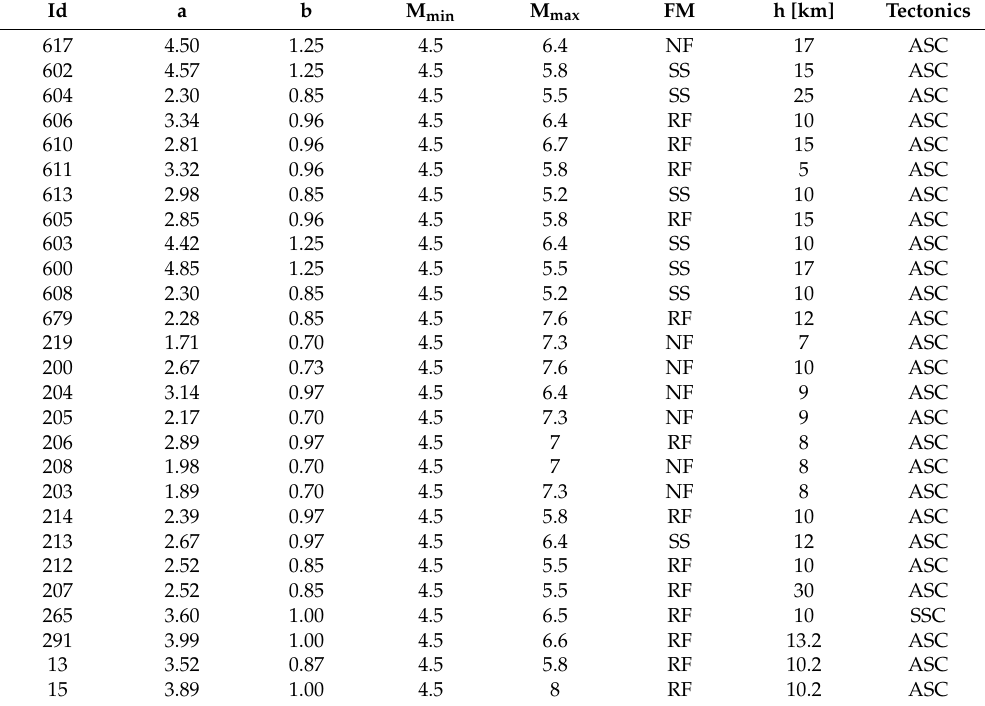
Table 8. Seismic characterization of each A1MPS16 zone [72]. a and b are the parameters of the Gutenberg–Richter distribution. M min and M max are the minimum and maximum moment magnitudes for PSHA. FM: Focal Mechanism; NF: Normal Faulting; SS: Strike-slip; RF: Reverse Faulting. h: Reference depth. ASC: Active Shallow Crust; SSC: Stable Shallow Crust.